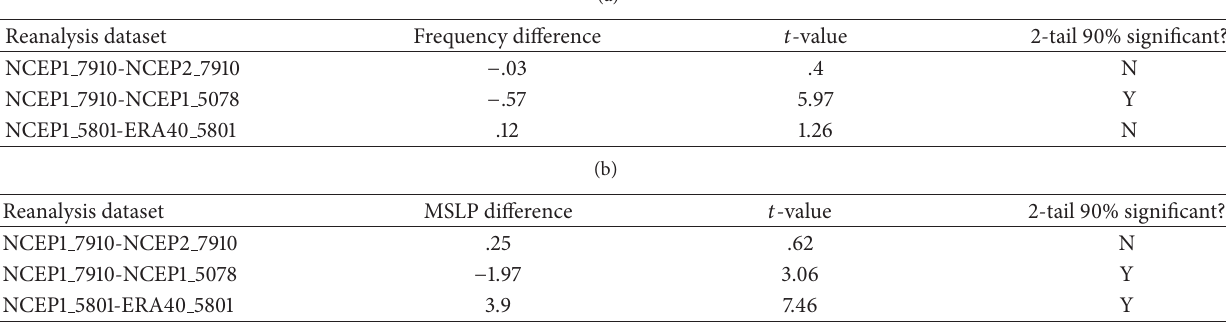
Table 3: Differences between reanalysis datasets and their significance for SH active cyclone track region (32.5 ∘ E–42.5 ∘ W, 52.5 ∘ S–67.5 ∘ S) for (a) frequency and (b)